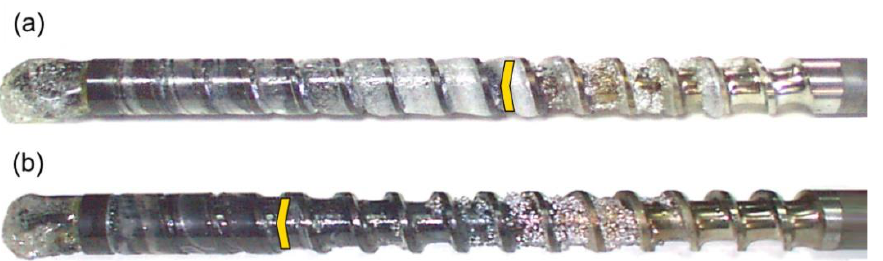
Figure 11. An effect of the plastication stroke on the polymer flow in the injection molding process at the screw speed N = 100 rpm, and the back pressure P back = 0 MPa: ( a ) h plast = 1 D, ( b ) h plast = 3 D.